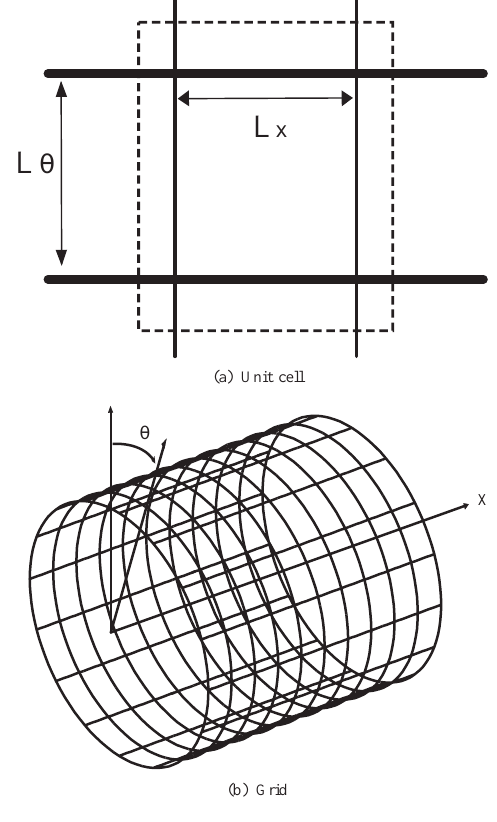
Fig. 1. Rectangular cell and